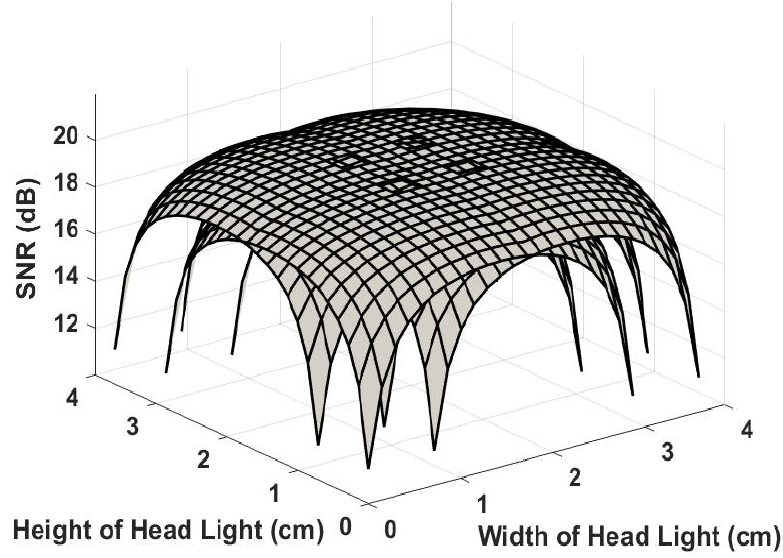
Figure 7. Improved SNR for the LED array using array gain from MISO transmission.